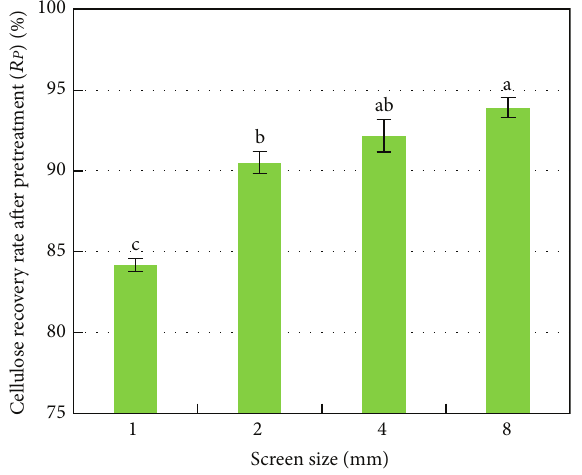
Figure 10: Effects of screen size on cellulose recovery rate after pretreatment.